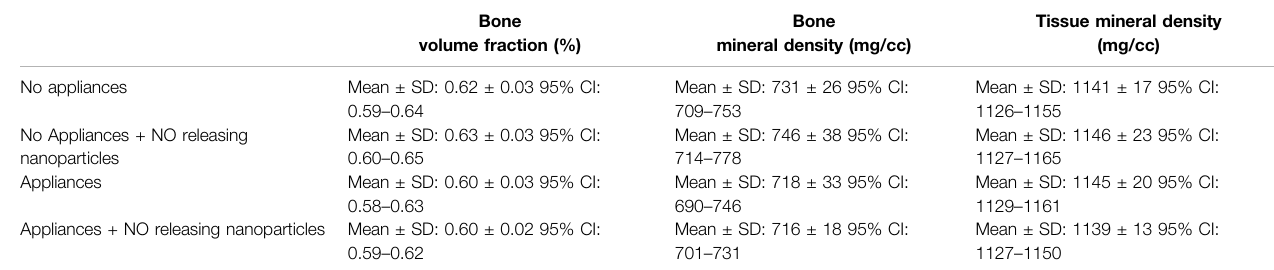
TABLE 3 | Cortical bone quality